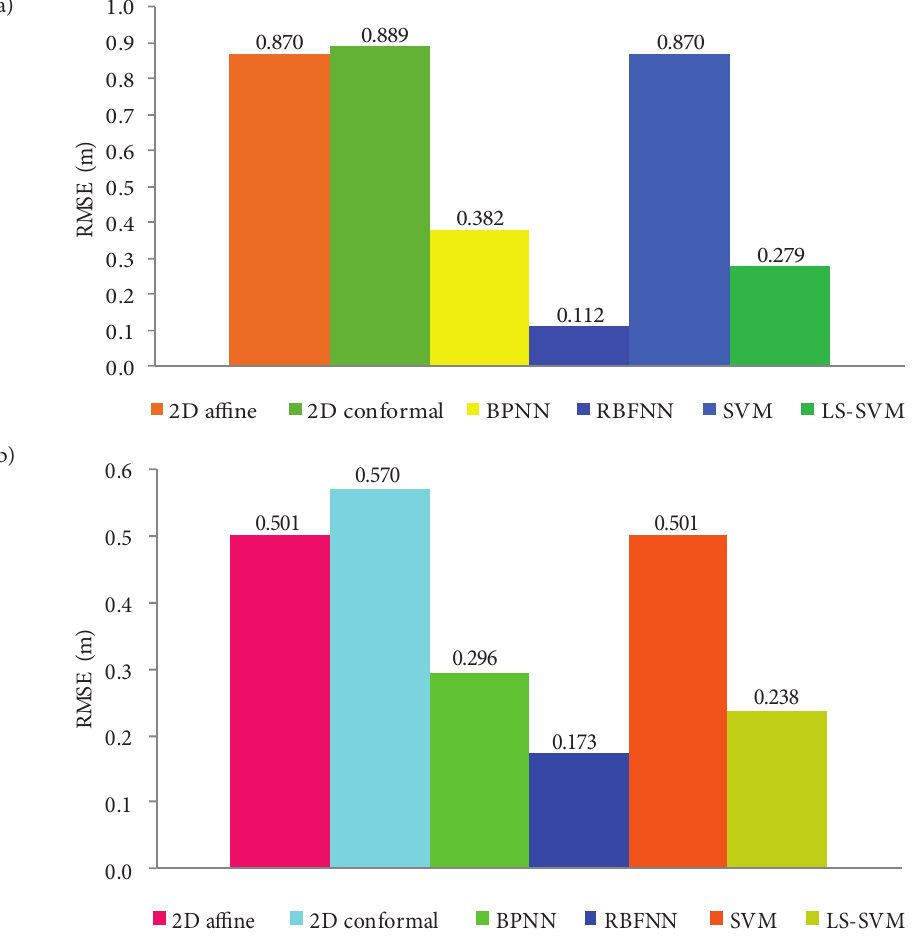
Figure 3. RMSE results of the methods based on the training data for (a) Easting and (b) Northing